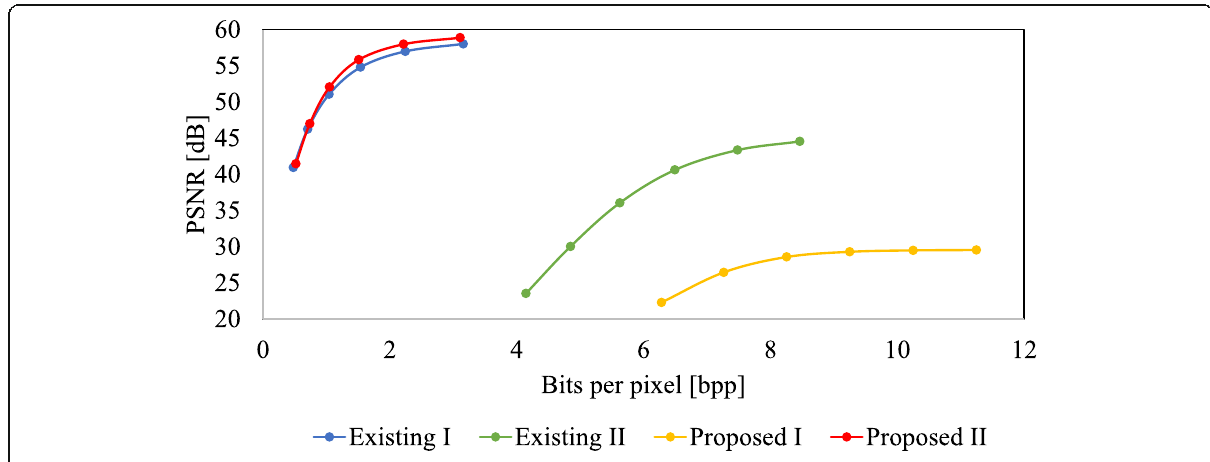
Fig. 19 Coding performance in lossy mode for CT image